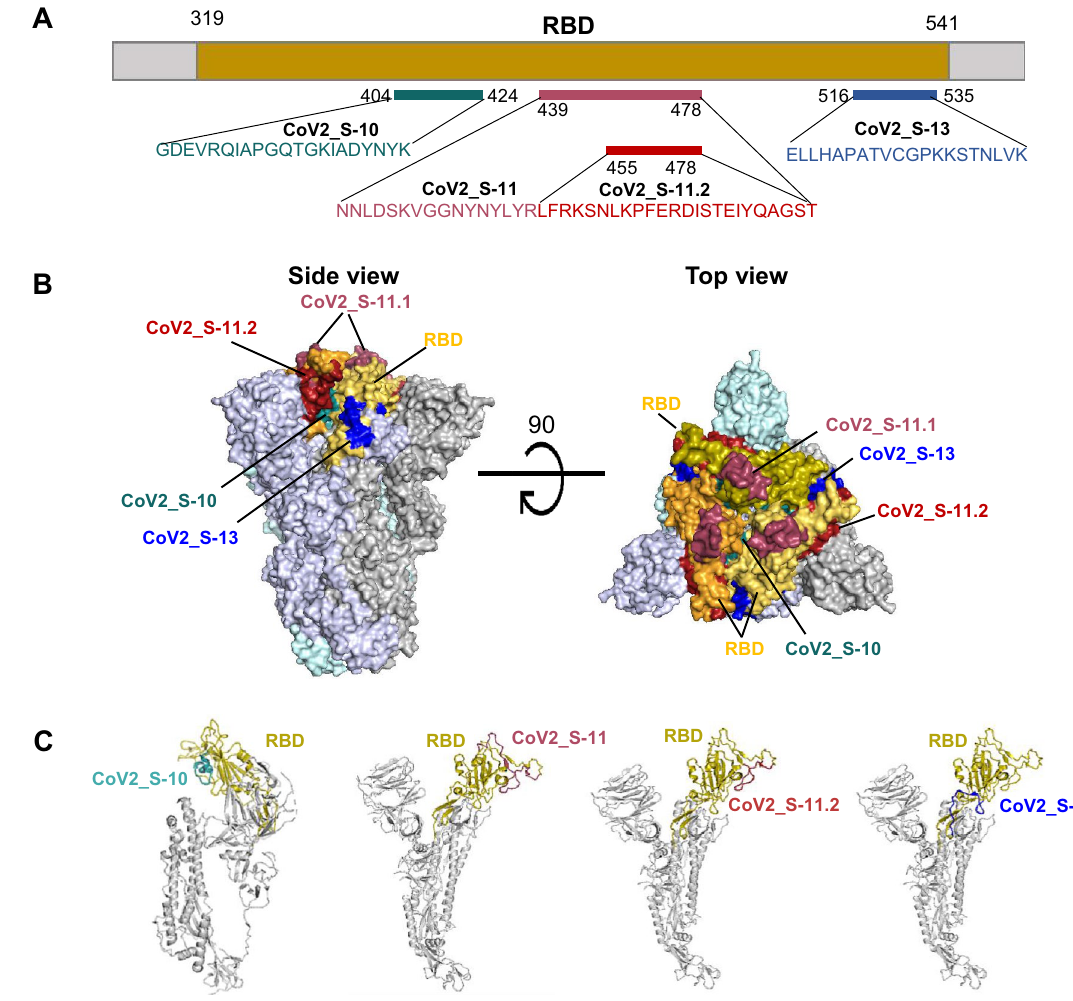
Figure 2. Sequences and locations of the immunodominant B cell epitopes in the RBD. ( A ) Sequences and positions of the three immunodominant epitopes in the RBD. ( B ) Surface representation of the immunodominant epitopes on the SARS-CoV-2 S trimer . ( C ) Locations of the immunodominant epitopes of the SARS-CoV-2 S monomer. The epitopes are labeled on the closed conformation of the 3-D S protein of SARS CoV-2 (PDB 6ZB5) using PyMOL 2.3.4 program. The RBD and immunodominant B cell epitopes are colored differentially as